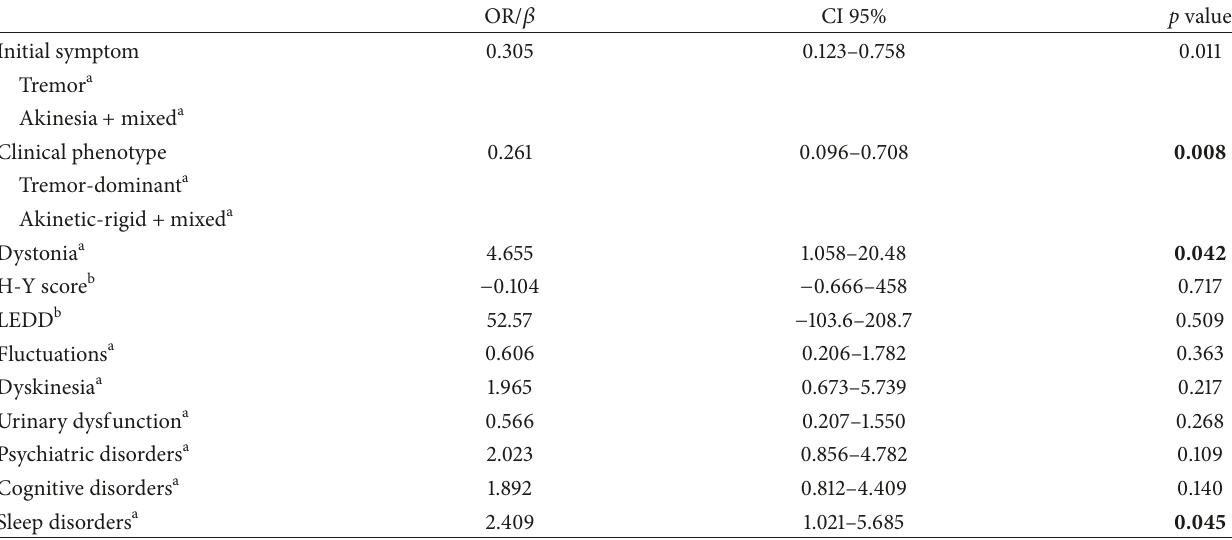
Table 4: Logistic regression model of the association between G2019S mutation and PD clinical features adjusted for gender, age, and disease